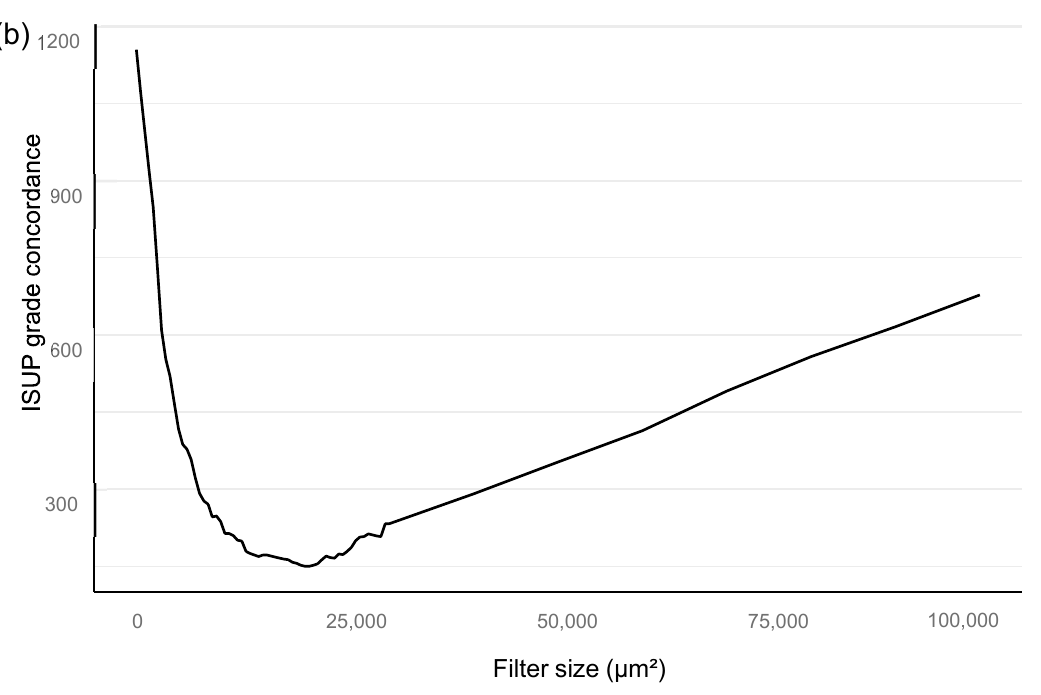
Figure 2. Bloom filter for the determination of the minimal filter size for benign versus malign tissue ( a ) and grade group difference ( b ) based upon clinical performance of the algorithm compared to clinical diagnosis.